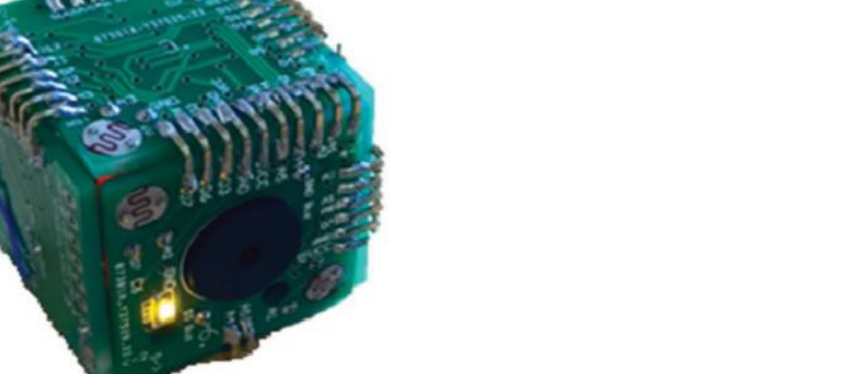
Figure 15. Smart cube for early detection of motoric impairments in childhood [32].